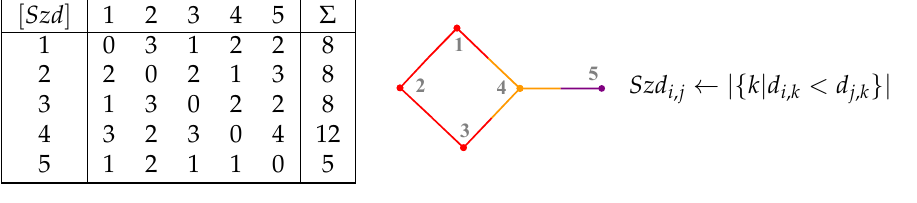
Figure 4. walk matrix on Figure